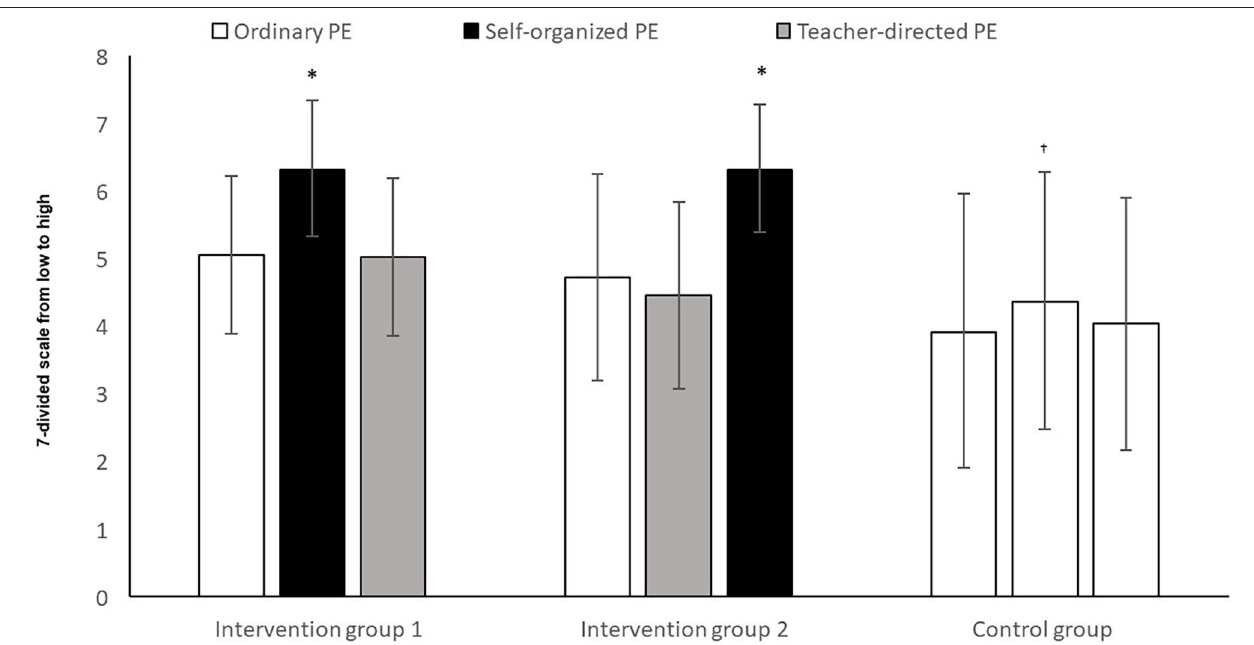
FIGURE 2 | Perception of having choice among the pupils after three periods of ordinary PE, teacher-led PE and self-determined. *Significantly greater perception of choice in self-determined PE, compared to ordinary and teacher-led PE ( p < 0.05). † Significantly lower perception of choice in the control group, compared to intervention groups 1 and 2 ( p <